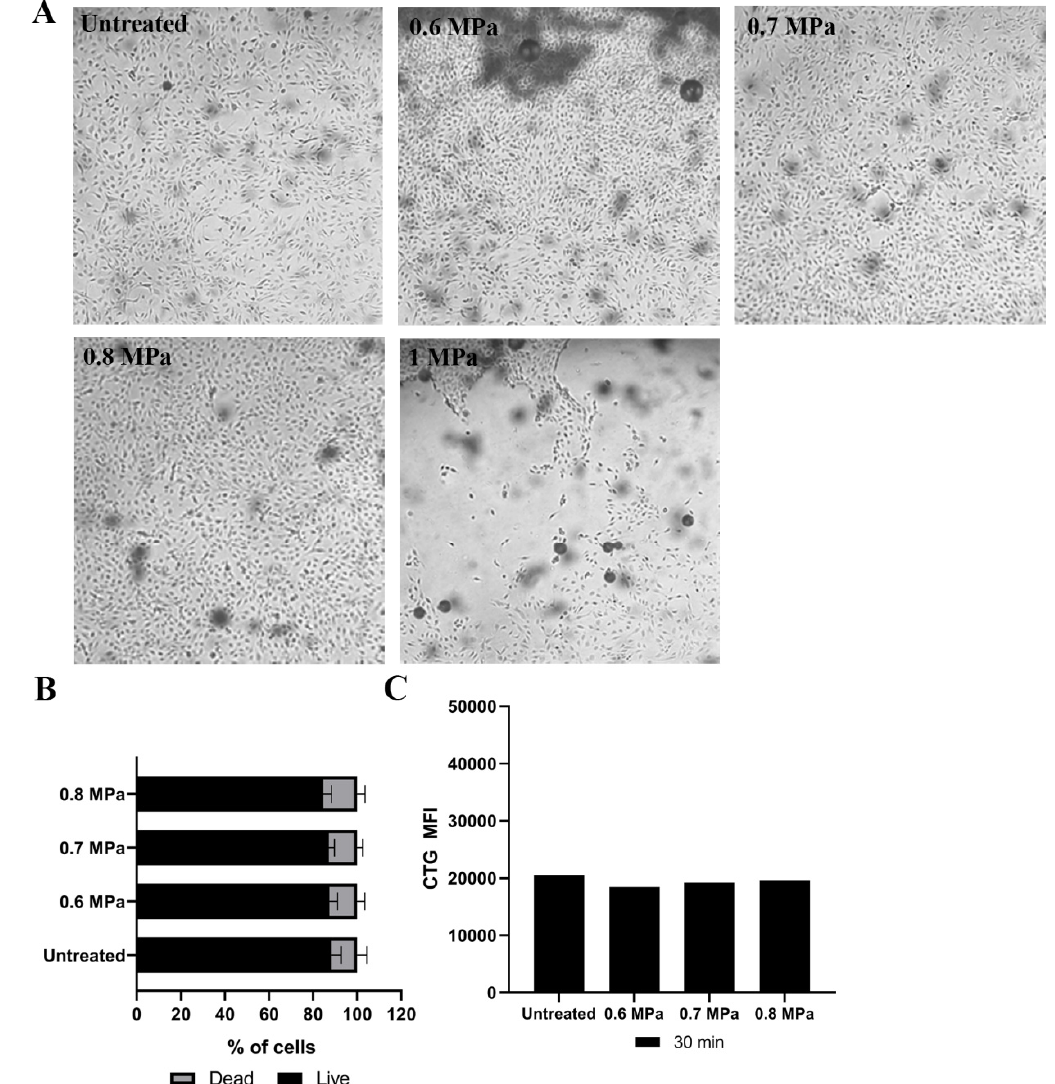
Figure 1. Human endothelial cells (HUVECs) stained with CellTracker™ green fluorescent dye (CTG) and treated at different ultrasound (US) acoustic pressures. Microscopy pictures of HUVECs captured before (untreated) and directly after US treatment (0.6, 0.7, 0.8 and 1 MPa) are presented at 10× magnification ( A ). Afterwards, cells were harvested and stained with PI to determine live and dead cells. The mean percentages of live and dead cells are presented ( B ). US acoustic pressures of 0.6, 0.7 and 0.8 MPa were tested to increase CTG signal intensities in HUVECs after incubation of CTG for 30 min ( C ). Untreated condition was HUVEs after incubation of CTG for 30 min. After 2 h of post-USMB, HUVECs were harvested and measured using flow cytometry ( C ). The mean fluorescent intensities (MFI) of CTG were presented ( C ). As a control, HUVECs without CTG staining were used. MFI results presented are the mean of two independent experiments.